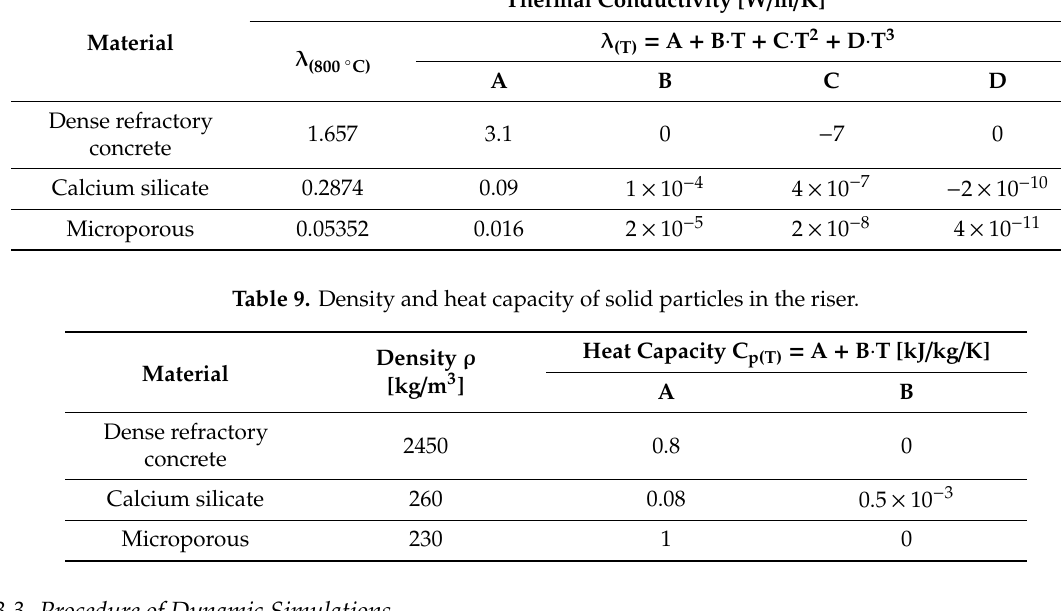
Tables 8 and 9: The refractory is made of three layers, starting with concrete at the inner layer via